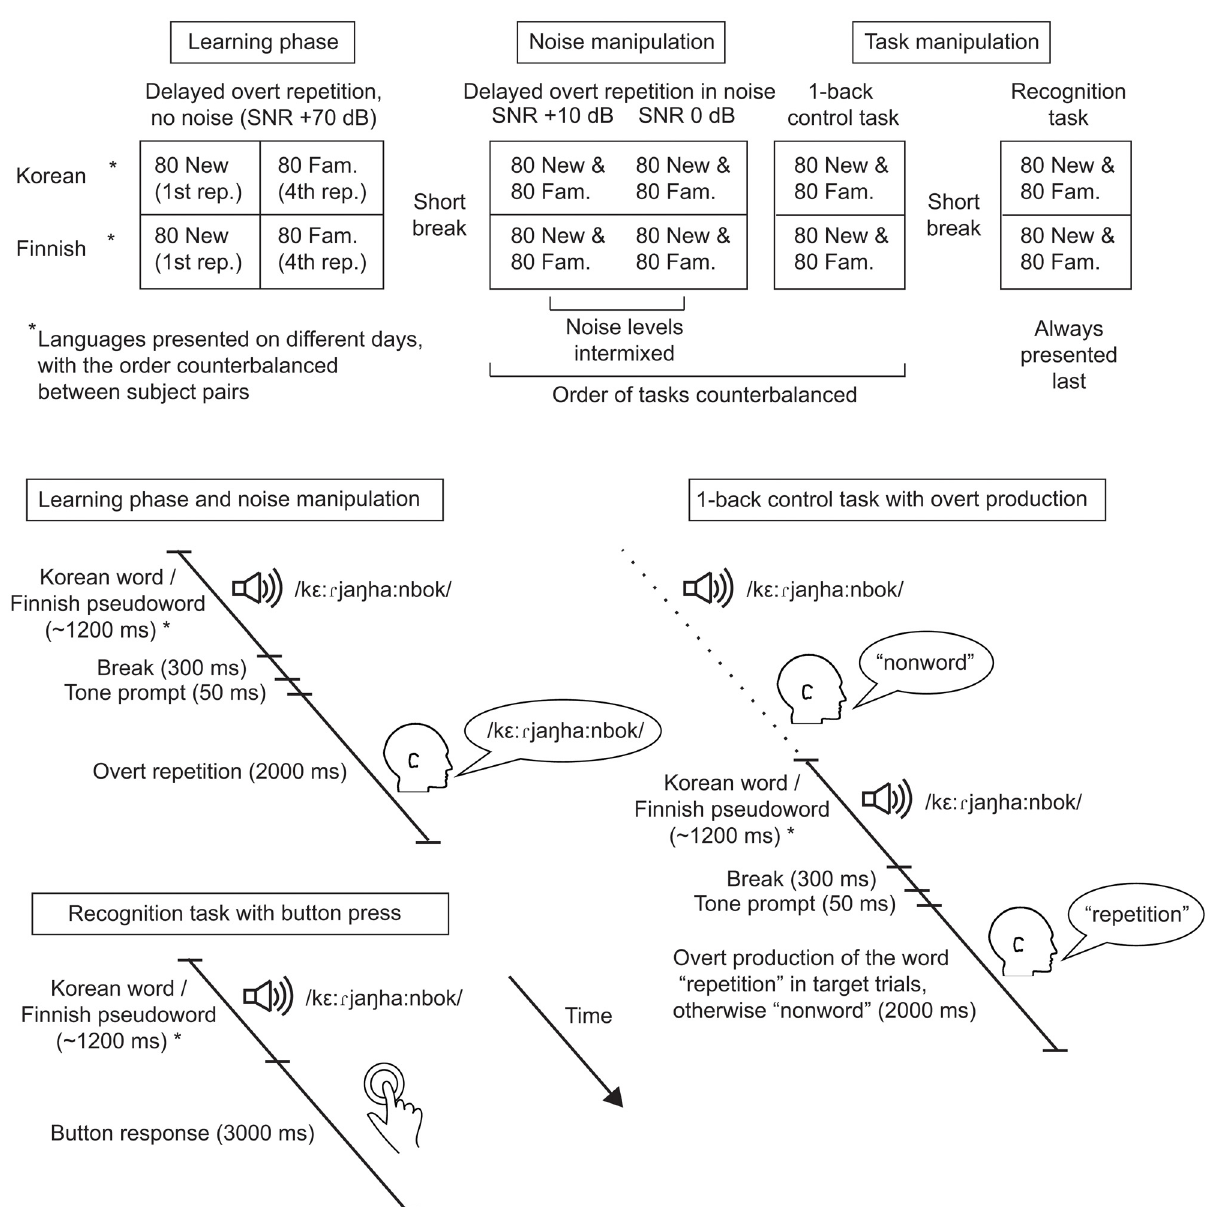
Fig 1. Experimental design. The initial learning phase with overt repetition was followed by two experimental manipulations, through noise and task. The noise manipulation included overt repetition of familiar and new word forms in two levels of noise. The task manipulation consisted of a 1-back control task and a recognition task that were performed on familiar and new word form stimuli. Stimulus presentation and response timing in the different experimental conditions is illustrated